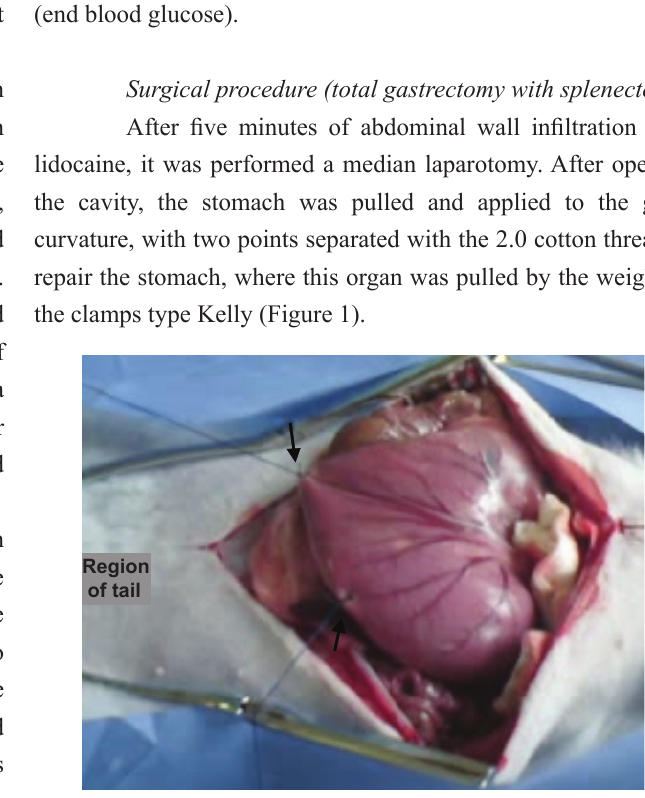
FIGURE 1 - Photograph demonstrating through the black arrows the reparation points with cotton performed in a great curvature to traction the